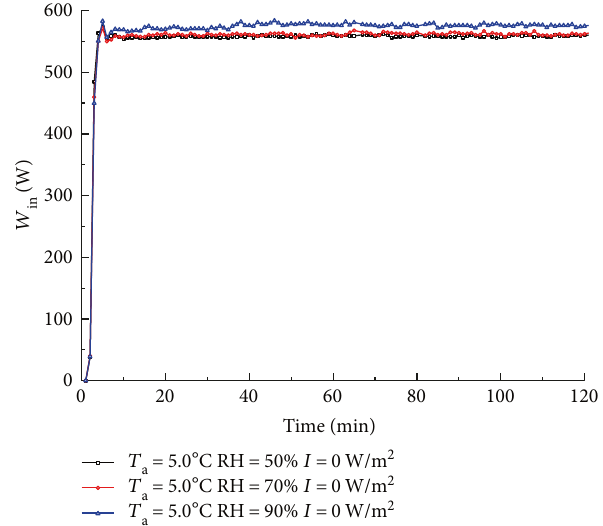
Figure 9: Variation of the energy consumption with the relative humidity of 50%, 70%, and